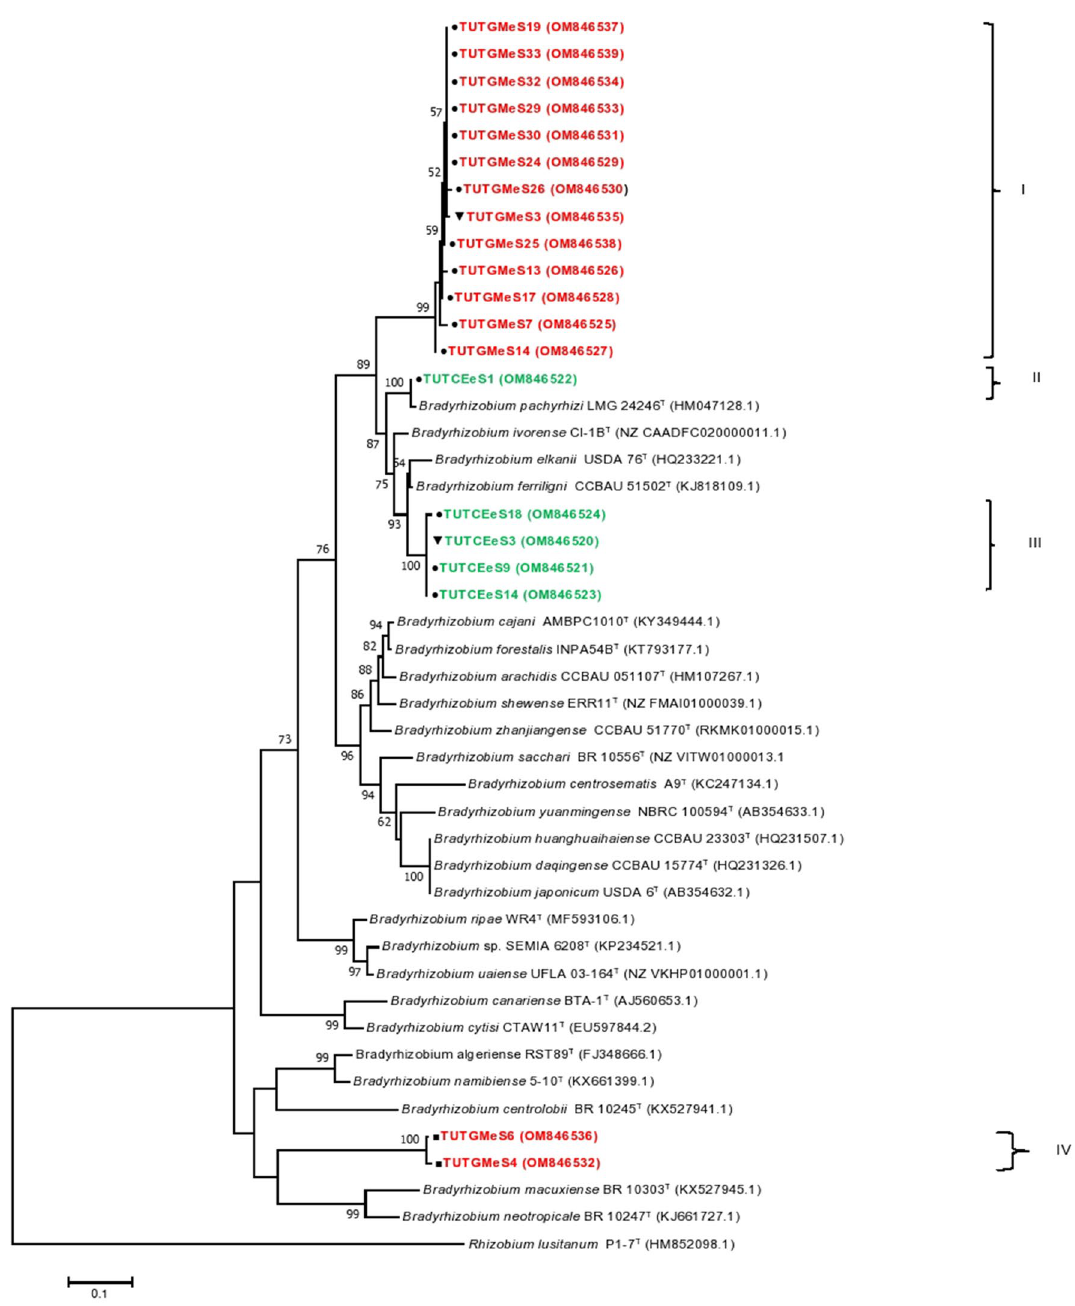
Figure 6. Maximum likelihood phylogenetic tree based on the nodC gene sequences of groundnut, jack bean and soybean isolates from various locations in Eswatini. For each isolate, the location of origin is indicated by assigning different symbols, e.g., circle-Malkerns Research station; square-New Heaven and triangle-Luve. GenBank accession numbers are indicated in parenthesis after the name of each isolate. Isolates’ names are colour coded based on the host species as Blue-groundnut, Green-jack bean and